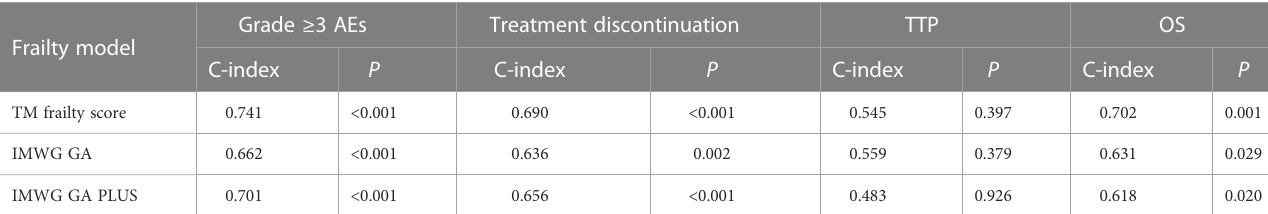
TABLE 5 Harrell ’ s concordance index (C-index) in different frailty assessment tools.